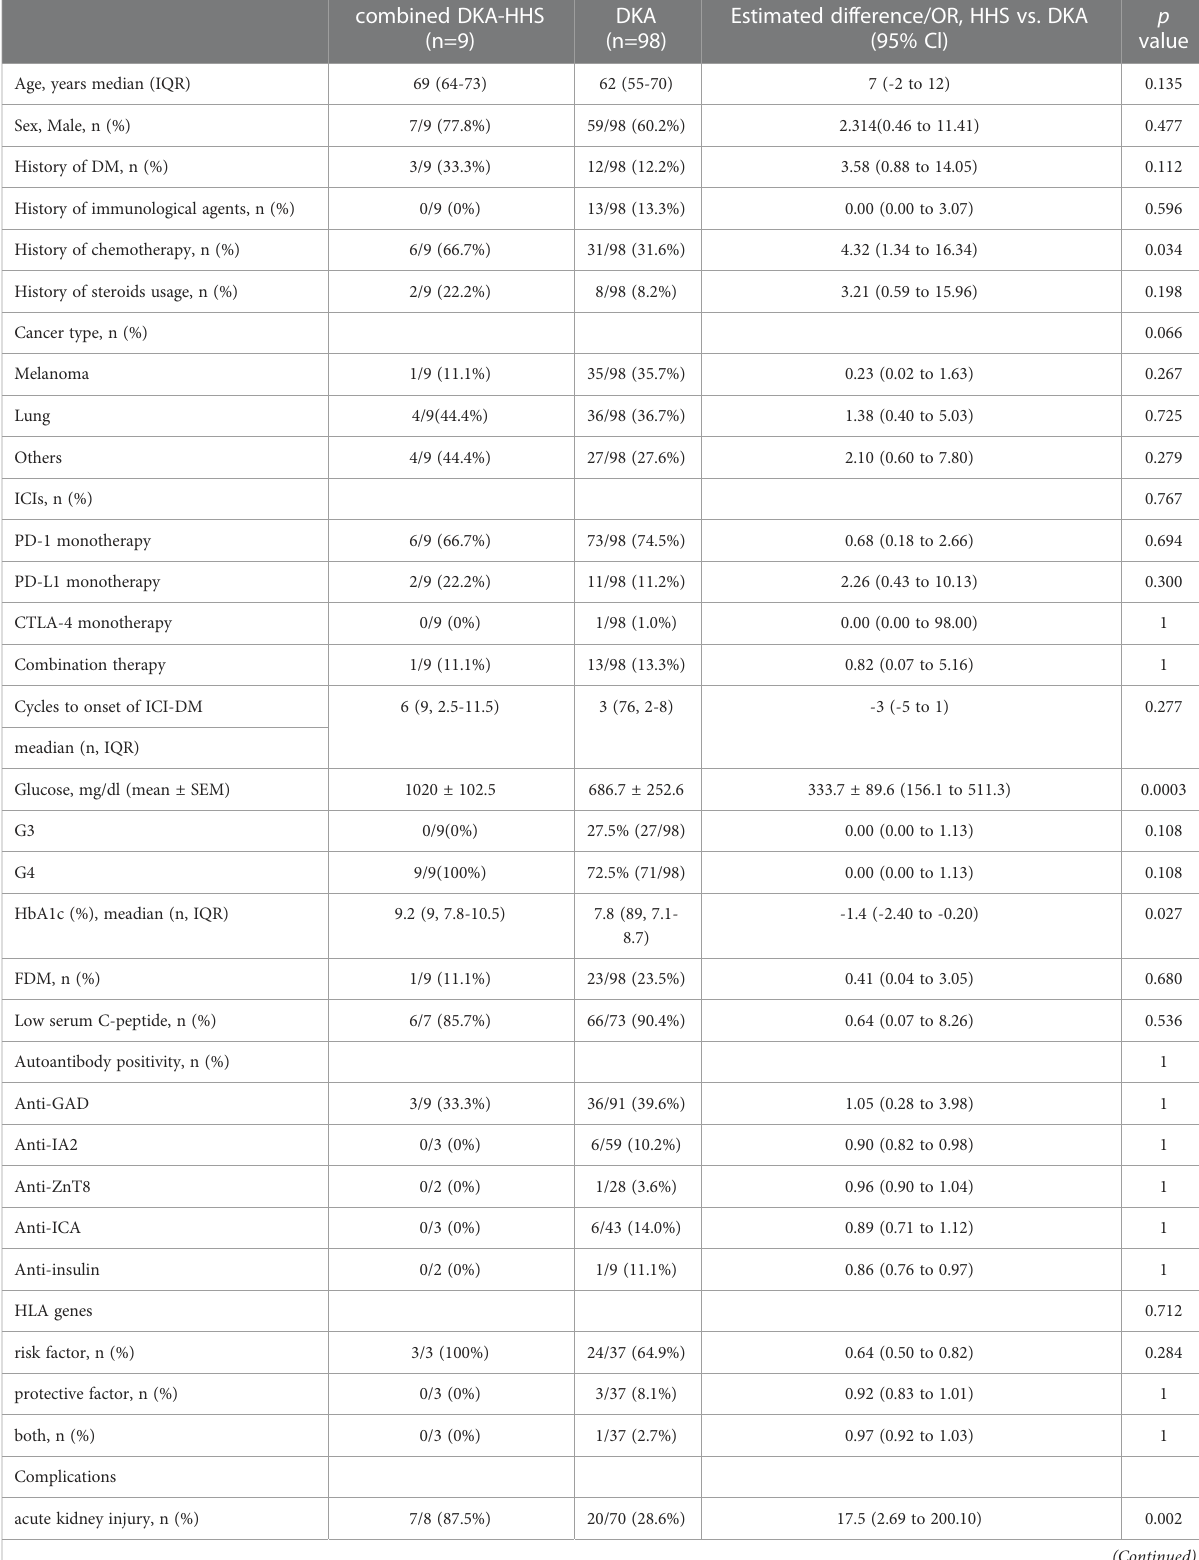
TABLE 1 The clinical characteristics of combined DKA-HHS and DKA secondary to ICIs